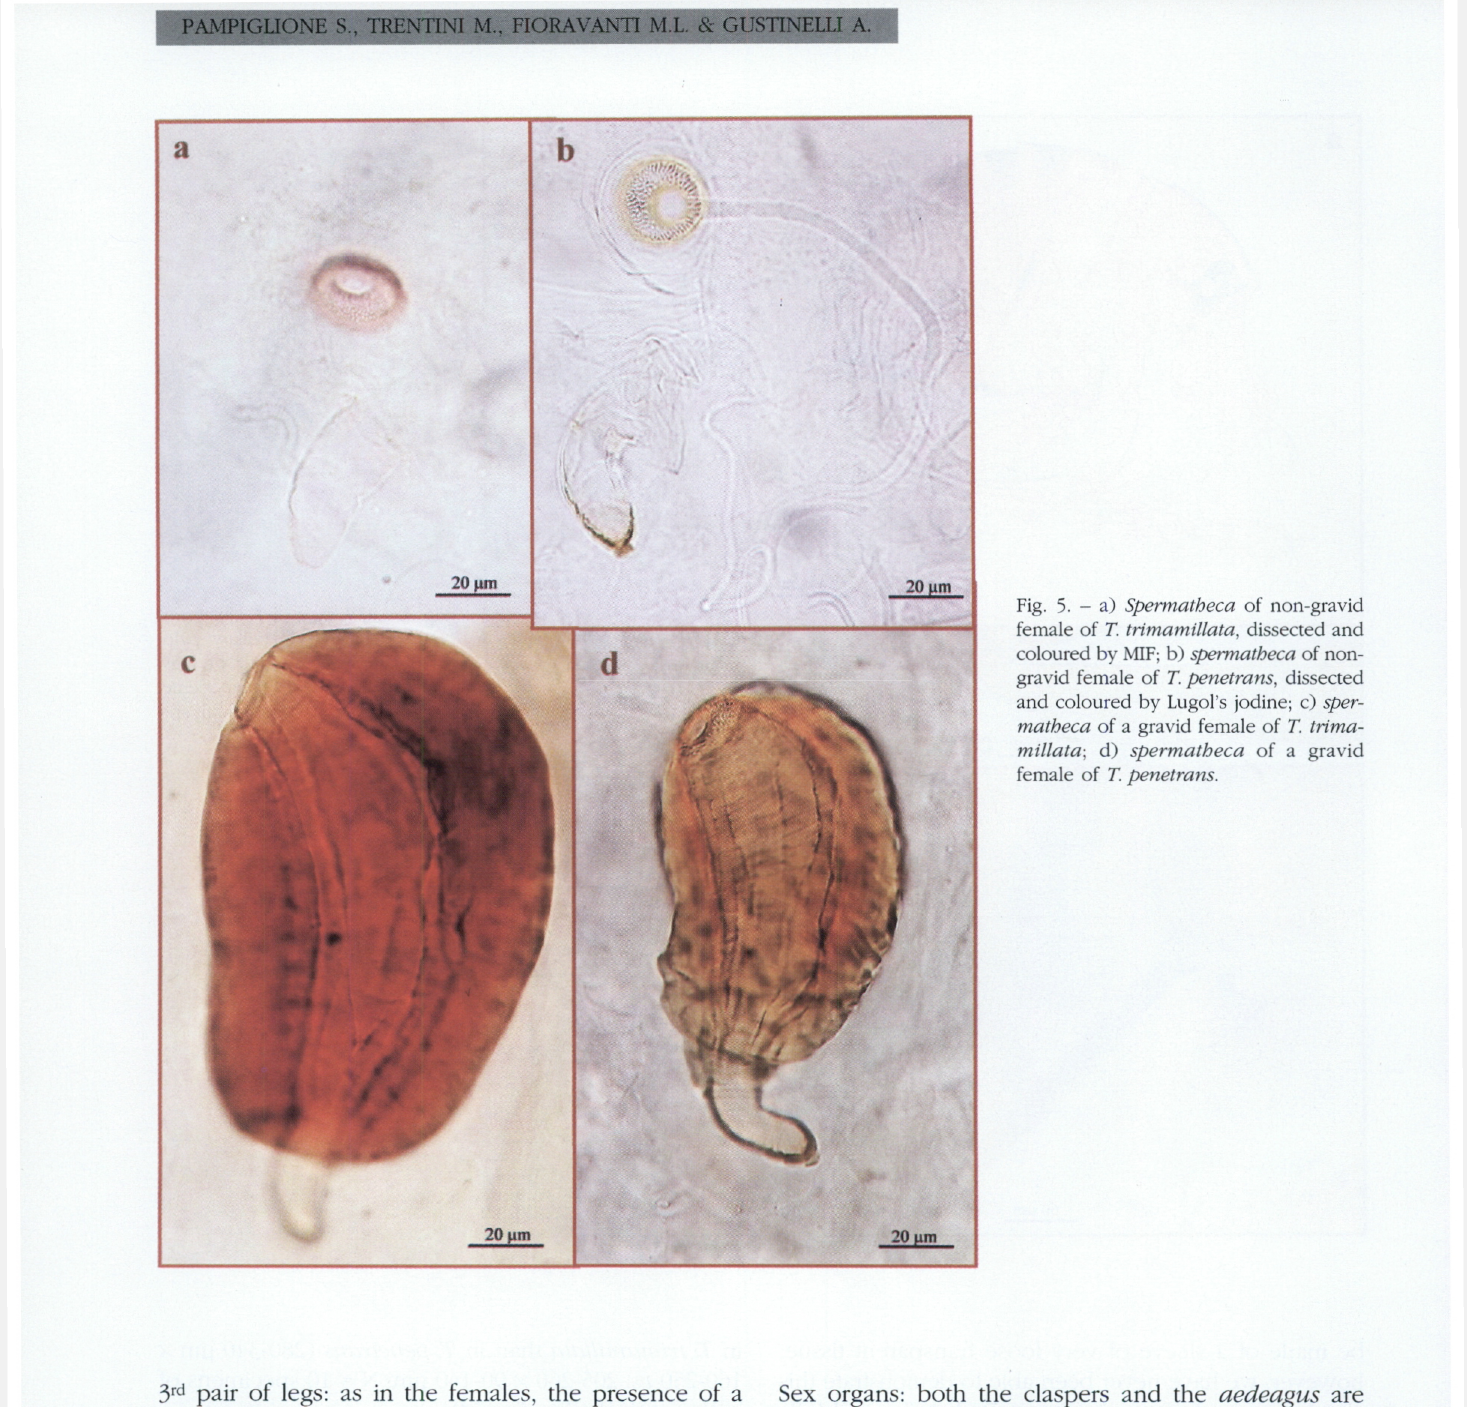
3rd pair of legs: as in the females, the presence of a row of spines on the antero-medial surface of the tibia is a constant finding in the male of T. trim am illata, while it is absent in T. penetrans (Figs 3c, 4c); and, again, as in the females, there are 9-13 spines on the edge of the 1st tarsal segment of males of T. trim a­ m illata while, in T. penetrans, the number is always less. Abdominal spiracles: in T. penetrans, they are in the form of a flower, having a diameter of 18-22 pm, with six more or less irregular “petals”; in T. trim am illata, they are less irregular, appearing more rounded and having a smaller diameter (10-12 pm) (Figs 3g,